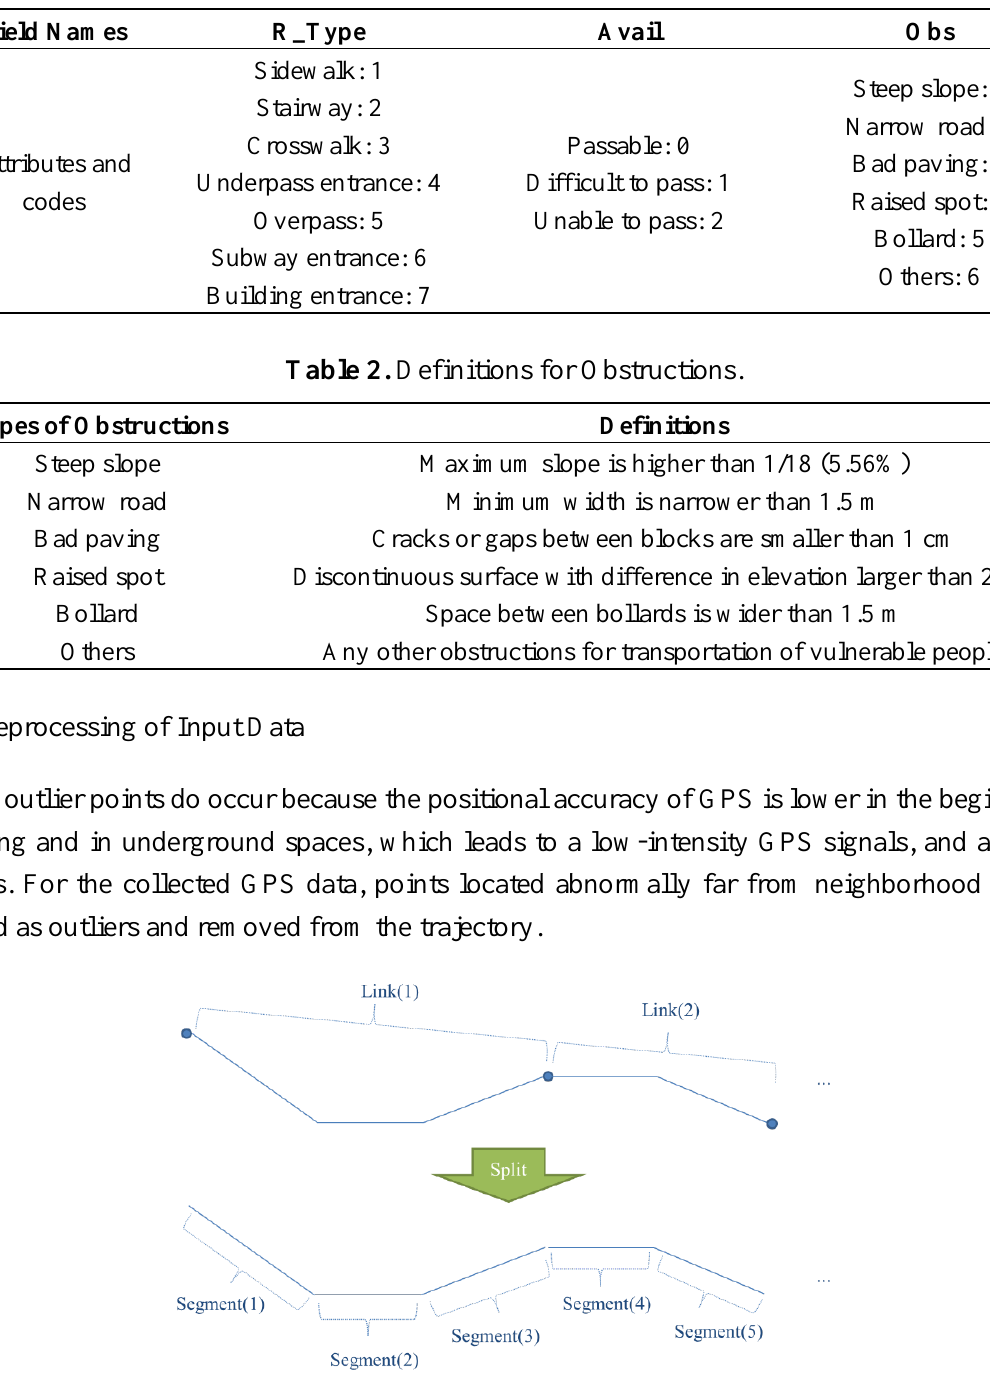
Table 1. Attribute Specifications of Facilities and Obstructions Information.